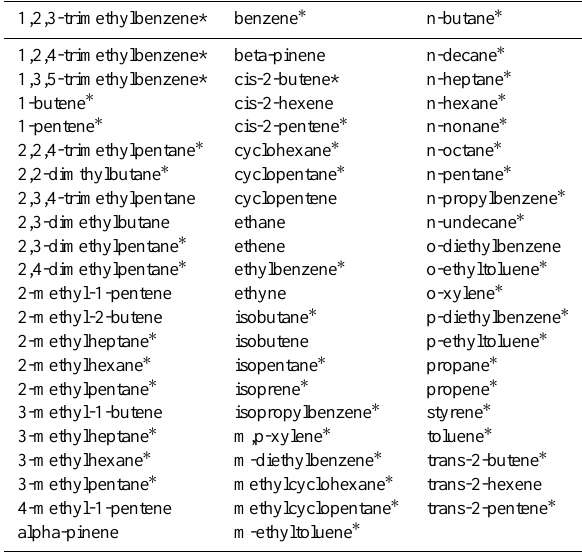
Table 1. The NMHCs measured in this